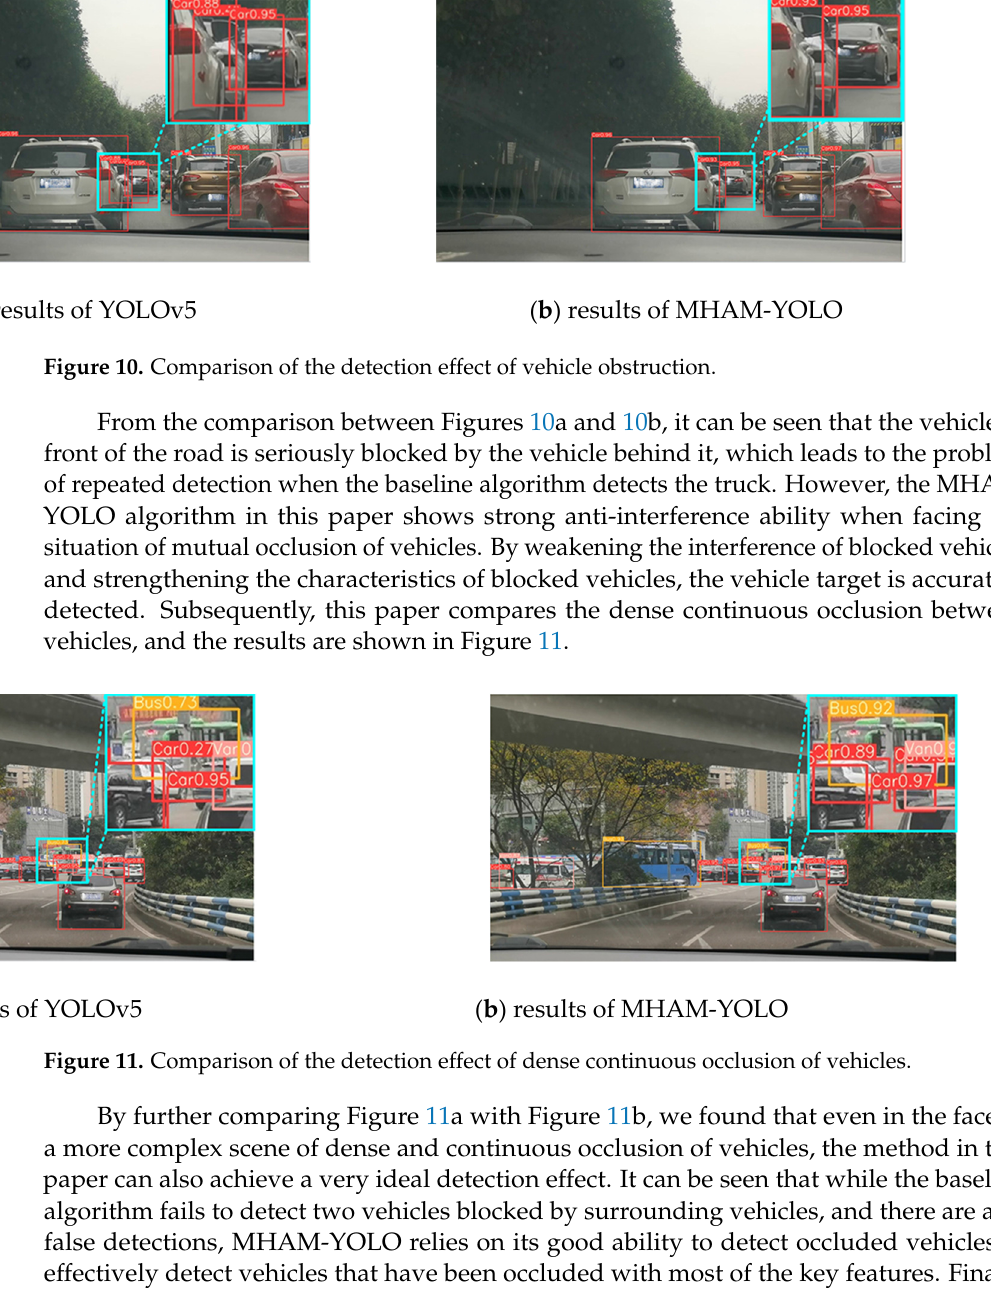
( b ) results of MHAM-YOLO Figure 12. Comparison of detection effects of irrelevant background information occlusion. The above analysis shows that the proposed road vehicle detection method MHAM- YOLO in occluded scenes can use the proposed multi-scale hybrid attention mechanism to well complete the task of detecting occluded vehicles. It can fully mine the important features of occluded vehicles by using the screening function of the attention mechanism, whether in the case of mutual occlusion between vehicles or the case of background infor- mation on vehicles. Hence, it can provide guidance for the detection process of target de- tector. 4. Conclusions An occluded vehicle detection method MHAM-YOLO based on multi-scale hybrid attention mechanism is proposed. A multi-scale hybrid attention module (MHAM) was